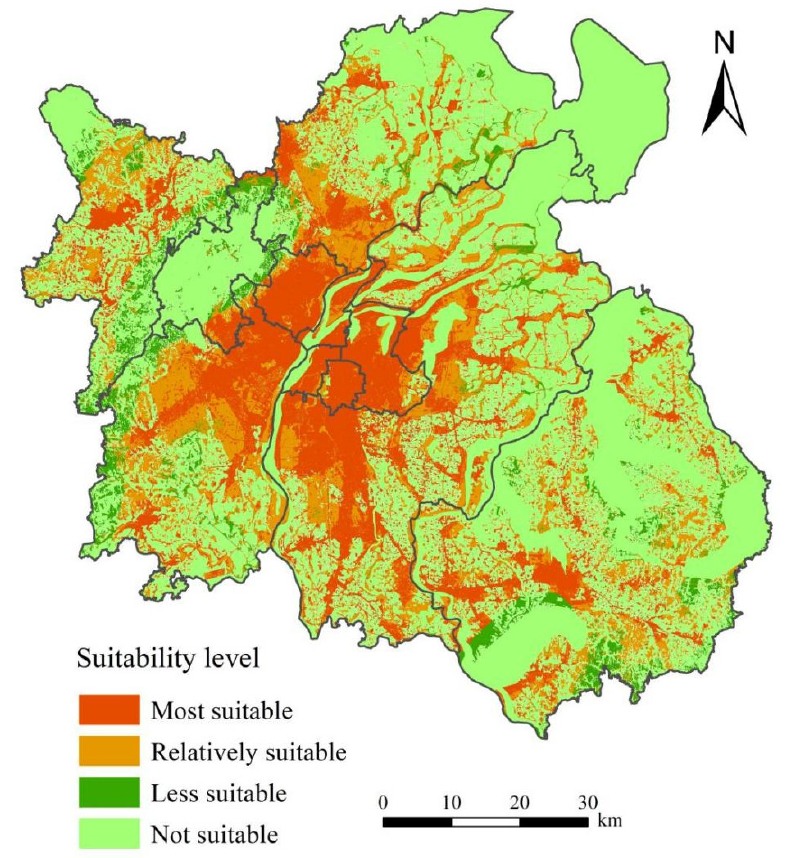
Figure 3. Spatial distribution of land suitability for urban-rural construction in the study region.